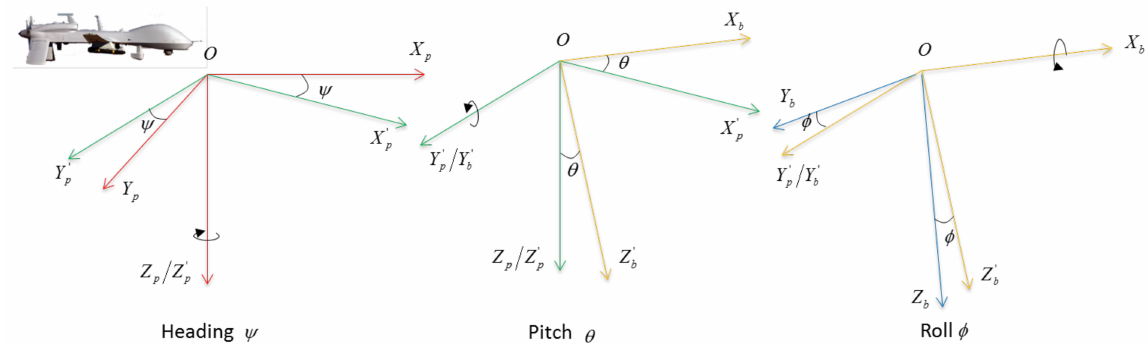
Figure 4. The aircraft coordinate frame and navigation coordinate frame.